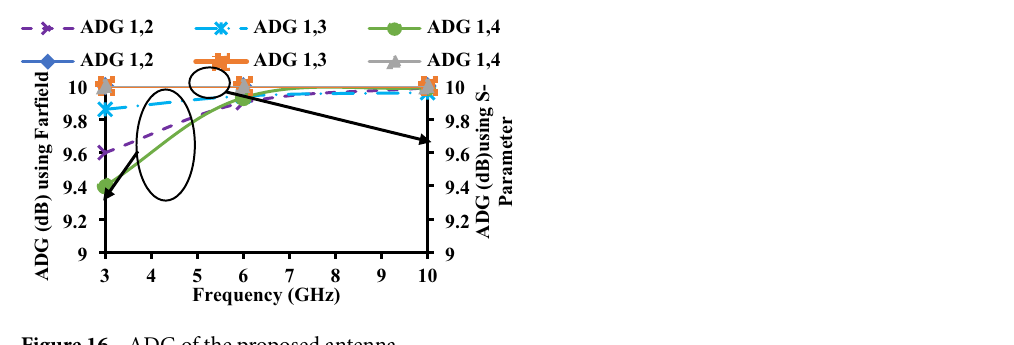
Figure 16. ADG of the proposed antenna.